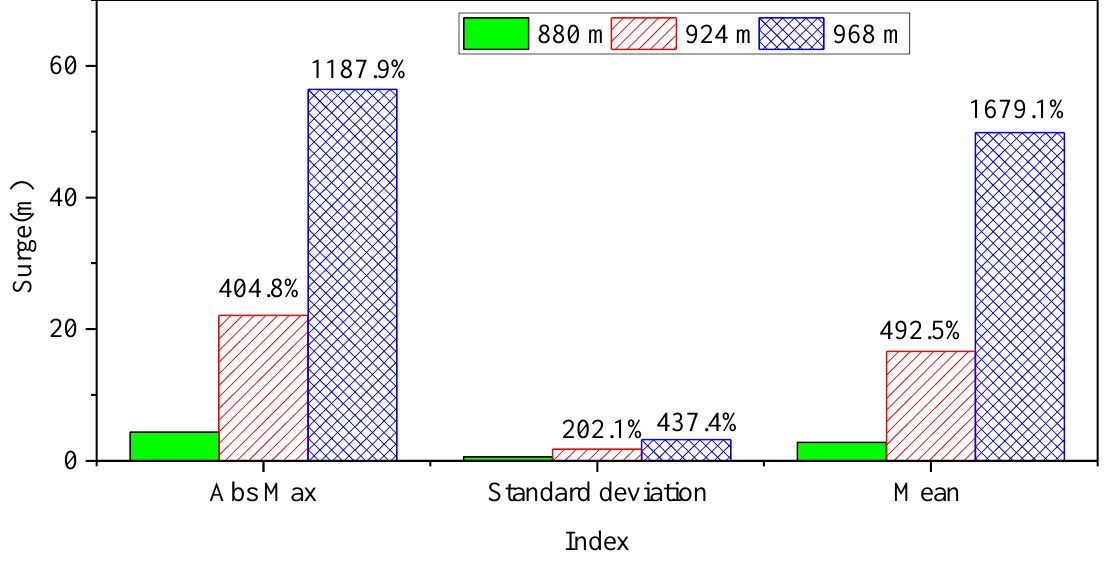
Figure 20. Statistics of surge responses for three line lengths.